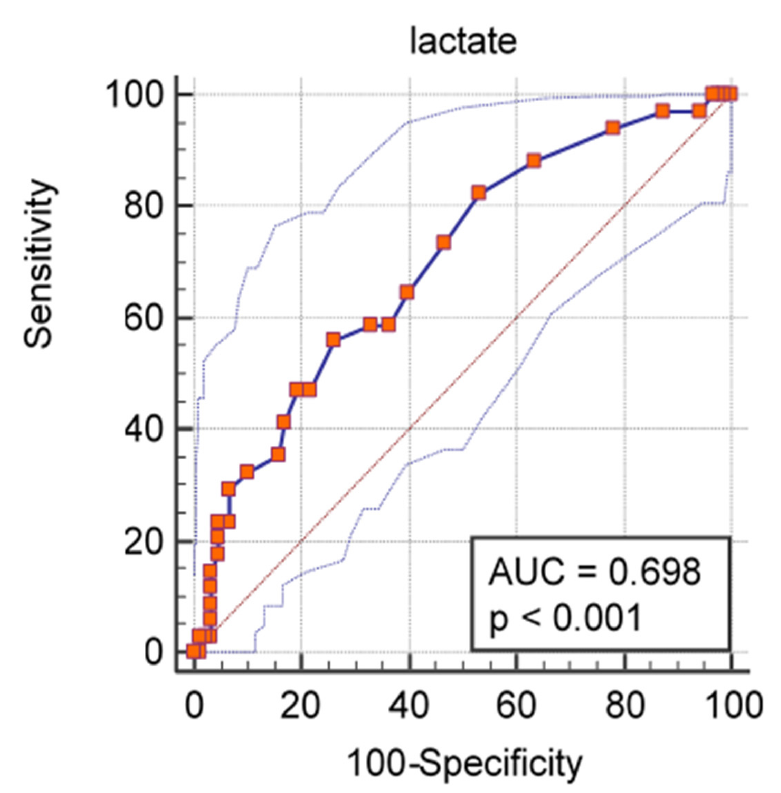
Figure 4. ROC curve and AUC values for lactate and ICU admission. Table 4. GOL2DS score. Best cut off sensibility and specificity values for lactate, PaO2/FiO2, LDH and SpO2. A score was assigned for each cut off value. The sum of the scores for each variable determines the GOL2DS score. Variable